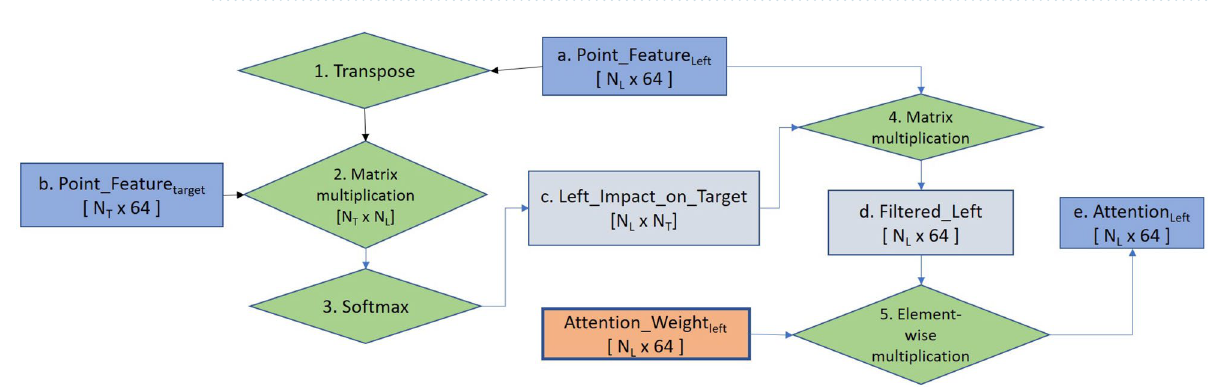
Figure 7. Flowchart of attention calculation in the IsoDetecting module. This particular flowchart is intended to find out the attention or impact of the left region over the datapoints of the target window. Exactly similar approach is followed for other surrounding regions as well and finally, all are diffused with the Point _ Feature target by ples. If a target window in a positive training sample prepared from peptide feature having charge ‘2’ contains features with other charges, e.g., ‘3’ and ‘4’, then the IsoDetecting module has to classify the datapoints belonging to not only charge ‘2’, but also charge ‘3’ and ‘4’. Therefore, the class sensitivity is impacted by the total amount of datapoints having that class, taking into account all the training samples. So we have included a column labeled as ‘Total Datapoints’ in Table 5. The positive and negative samples are generated from the validation LC-MS map similarly and presented in the table as well. Technical details on training and validation of IsoDetecting module. We use a minibatch size of 8 during the training because the network already takes about 15 GB GPU Memory due to the sophisticated architecture. We use ‘NAdam’ stochastic optimization 32 with initial learning rate of 0.001. We check the accuracy on validation set after training on every 1200 training samples. If we do not observe any significant drop in the validation loss